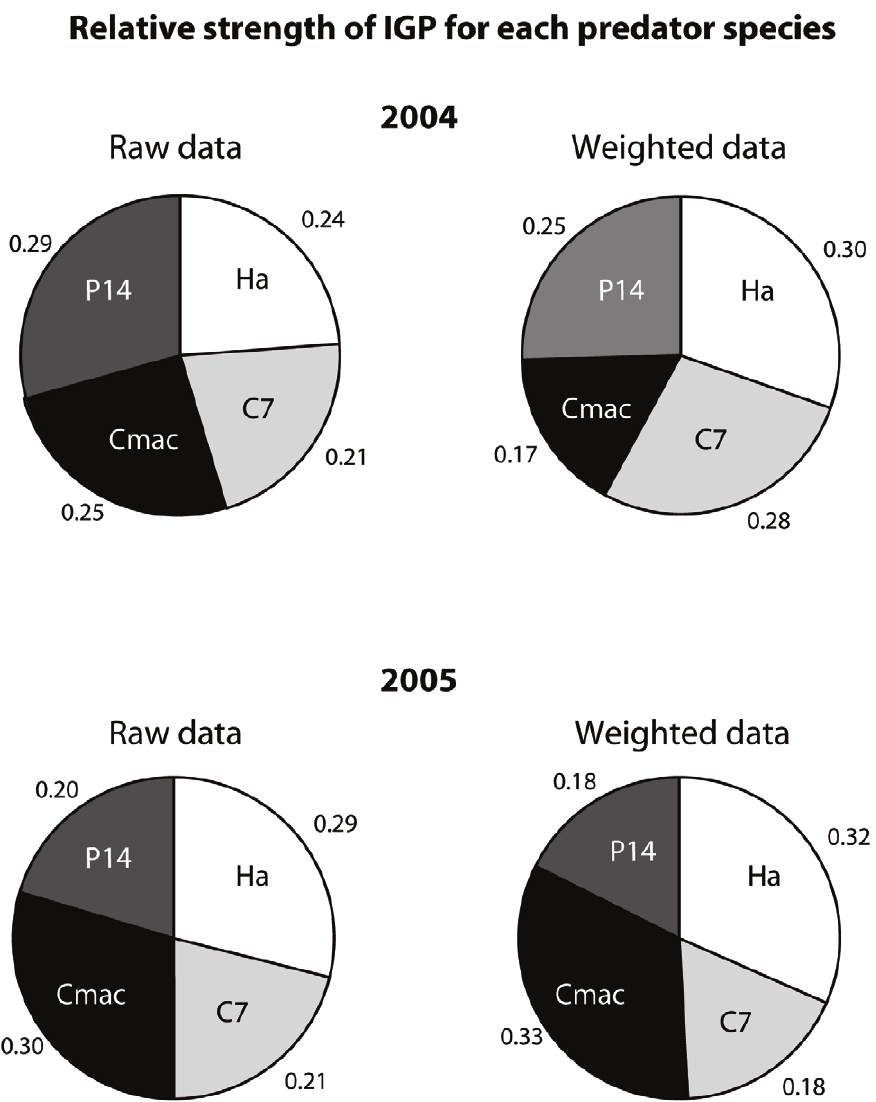
Figure 2. Relative strength of intraguild predation by each of the four coccinellid species measured by molecular gut content analysis in soybean fields in Que´bec, Canada, in 2004 and 2005. Results are shown for raw and weighted data*. Ha= Harmonia axyridis , C7 = Coccinella septempunctata , Cmac = Coleomegilla maculata , P14= Propylea quatuordecimpunctata .